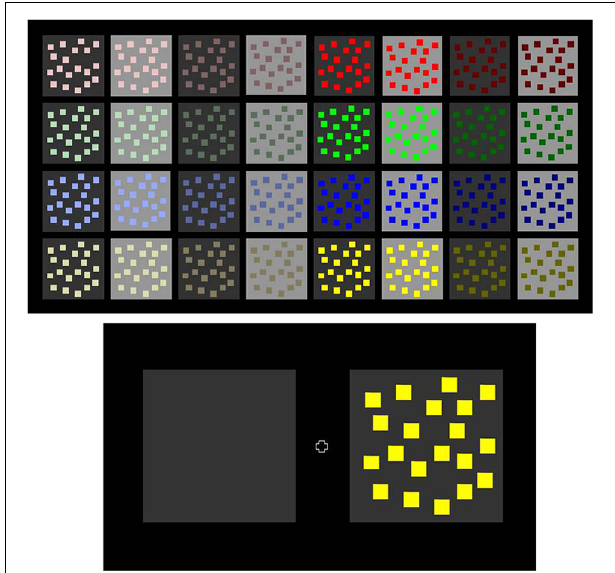
FIGURE 3 | We varied the luminance contrast and saturation (as shown in the upper panel here) of colored inducers presented on gray backgrounds. In the relative background brightness task, observers had to judge the relative brightness (brighter, darker, or same) of a gray test background with inducers in comparison with a simultaneously presented background field, of identical luminance but without inducers (as shown in the lower panel here). In this pair of configurations, 90% of subjects perceive the gray background with inducers on the right as darker than the plain comparison background on the left, a typical subjective contrast effect. In the relative inducer depth task, observers had to indicate the relative depth of the inducers in single inducer-background configurations (there was no comparison field). They had to decide whether inducers are seen as standing in front or behind the gray background, or whether inducers, and background appeared to lie in the same plane. In the configuration shown on the right of the lower panel here, 95% of subjects perceive the colored inducers as standing in front of their gray background, a typical foreground